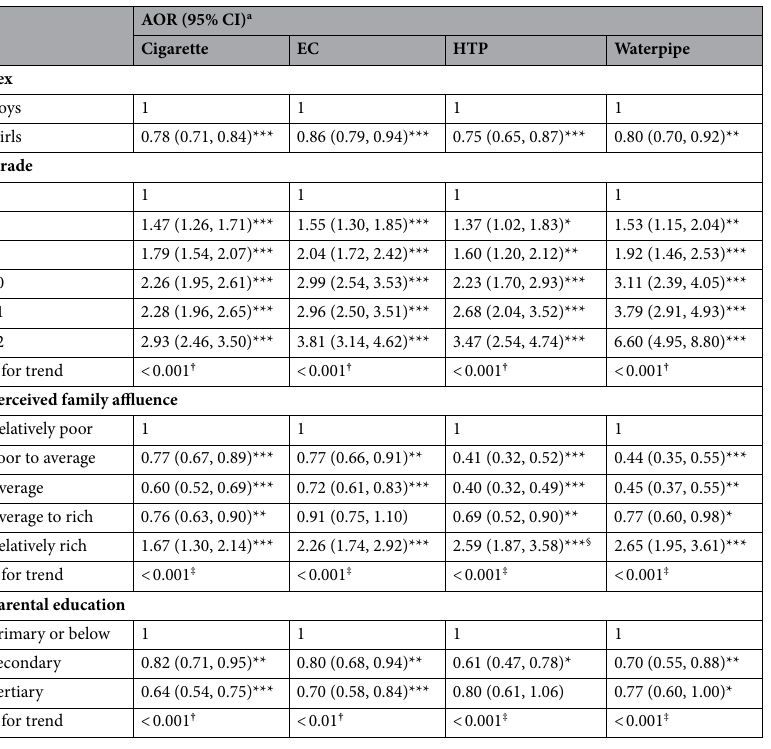
Table 2. Associations between sociodemographic factors and ever (vs never) tobacco use in Hong Kong secondary school students. * P < 0.05, ** P < 0.01, *** P < 0.001. † Linear trend. ‡ Curvilinear (quadratic) trend. § Interaction with sex. EC, e-cigarette; HTP, heated tobacco product; AOR, adjusted odds ratio; CI, confidence interval. a Adjusted odd odds ratios adjusted for sex, grade, perceived family affluence, parental education, and school clustering